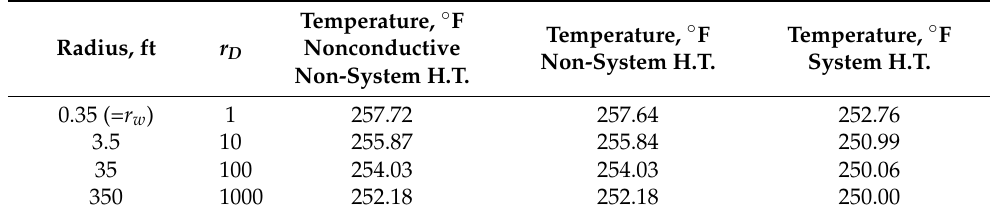
Table 3. Radial temperature results from the three steady-state models: the nonconductive non- system H.T. model, the non-system H.T. model, and the system H.T. model.